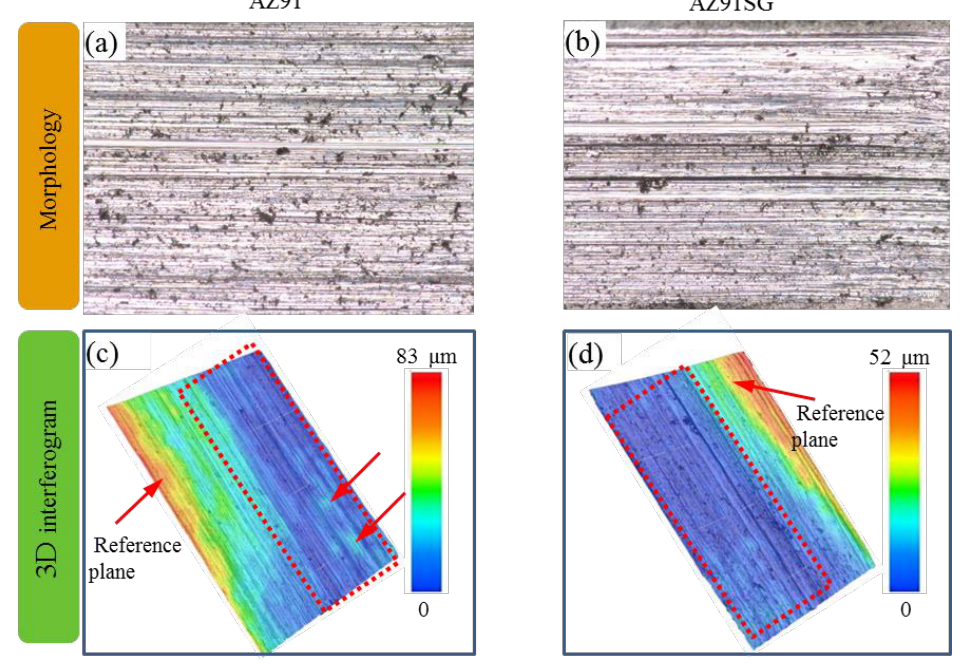
Figure 7. Optical images of wear tracks, 3D interferograms showing wear track profile for ( a,c ) AZ91 and ( b,d ) AZ91SG, respectively.